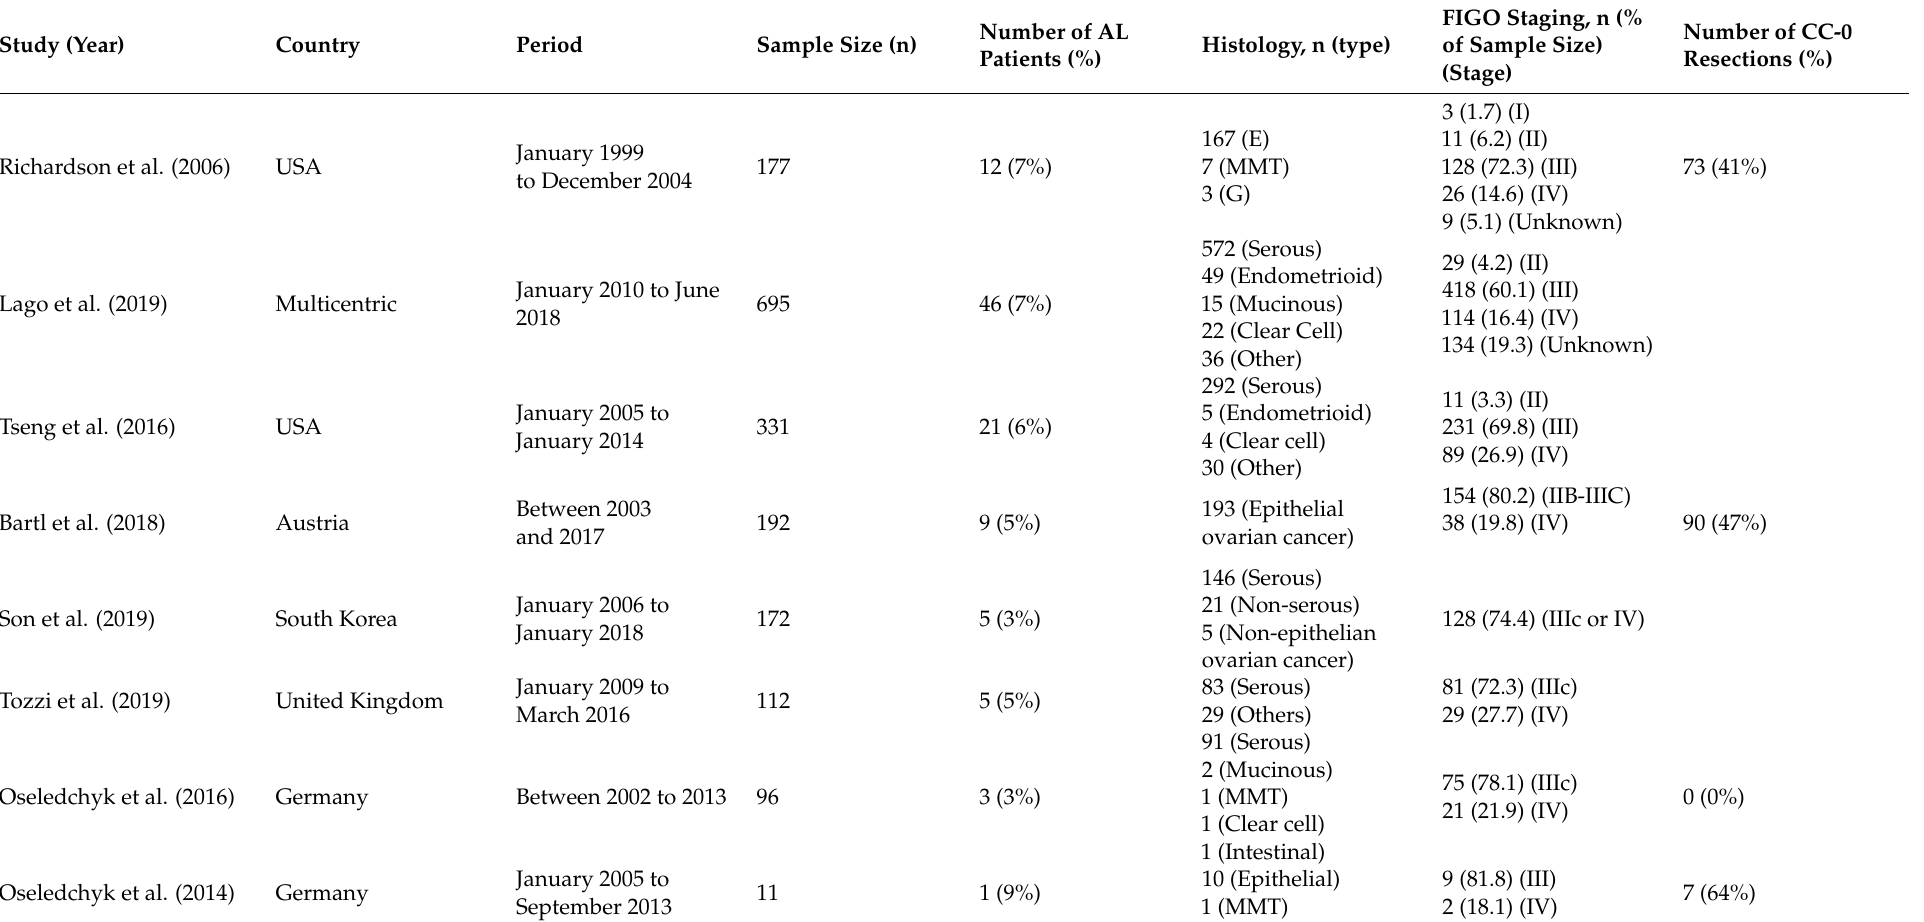
Table 1. Basic characteristics of the included studies. Anastomotic leak (AL), Epithelial (E), Malignant Mixed Mullerian Tumor (MMT), Granulosa cell